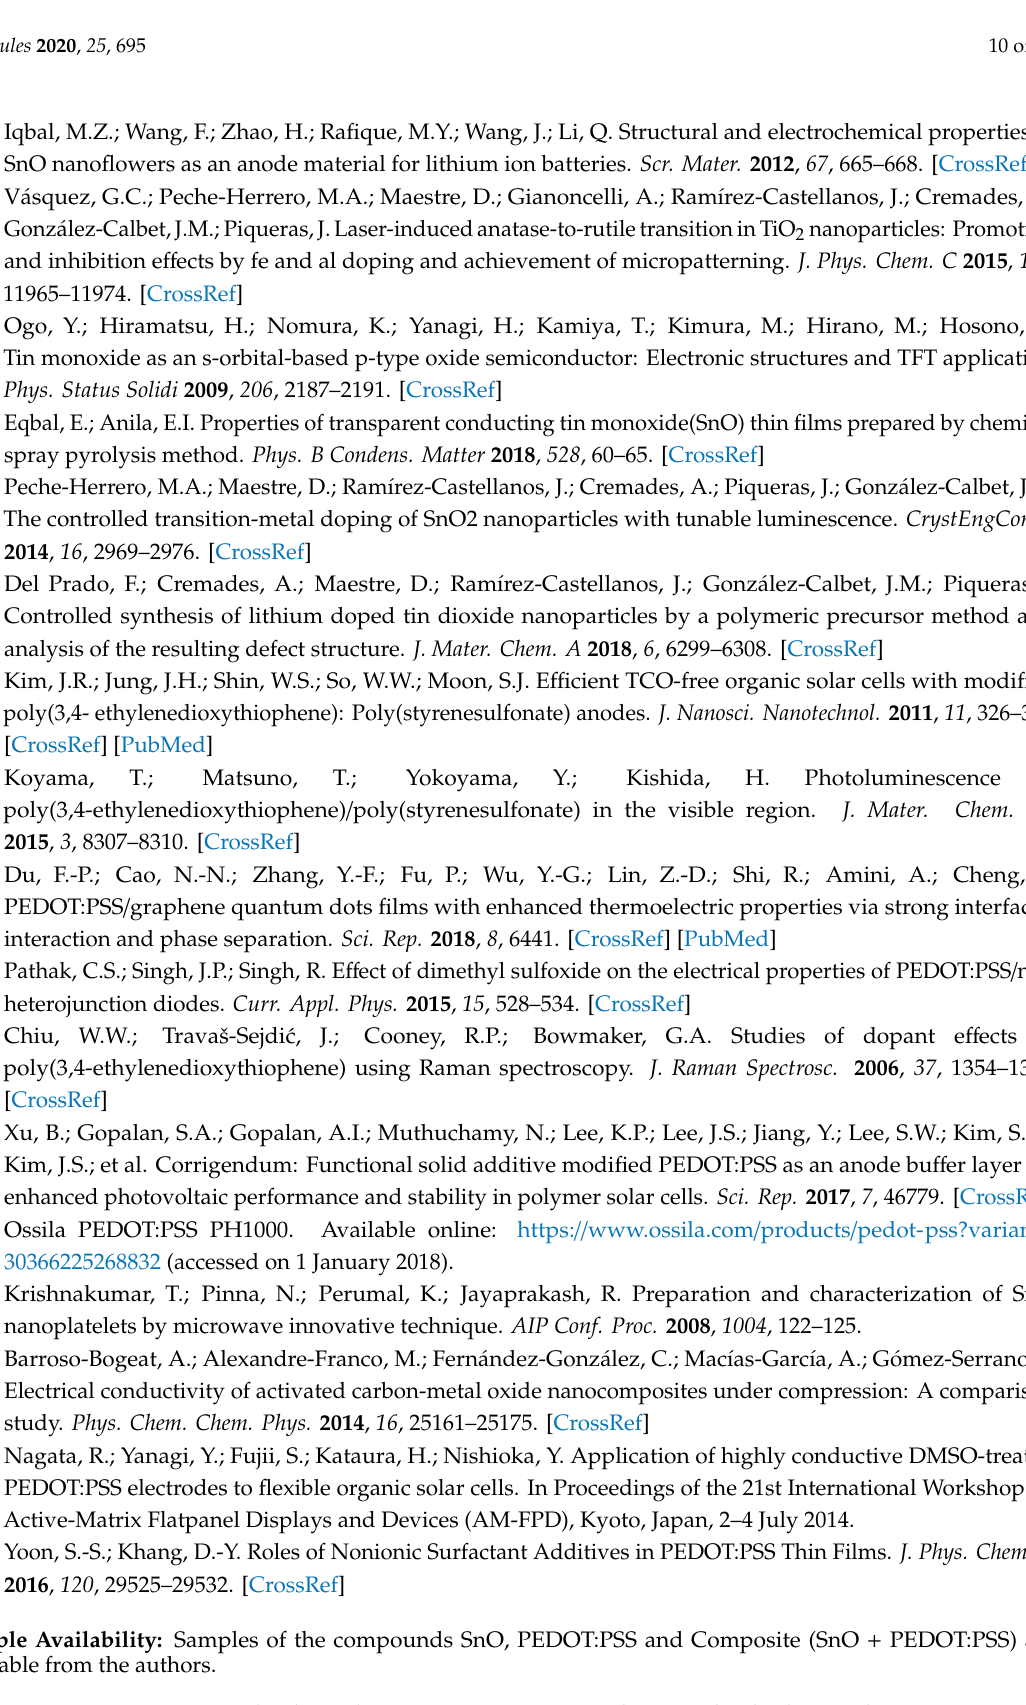
Sample Availability: Samples of the compounds SnO, PEDOT:PSS and Composite (SnO + PEDOT:PSS) are available from the